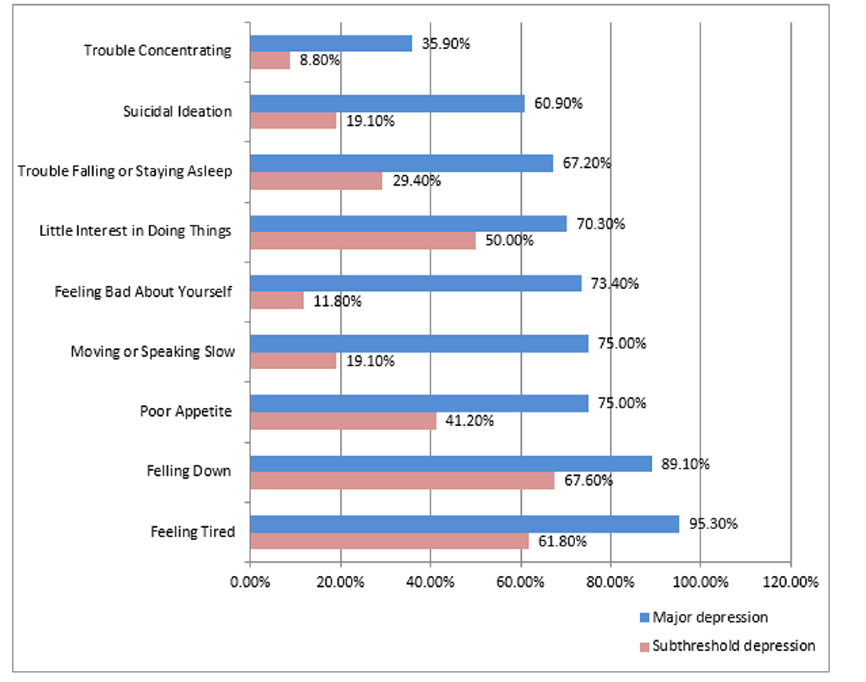
Fig 3. Proportions of depressive symptoms among the depression subtypes.